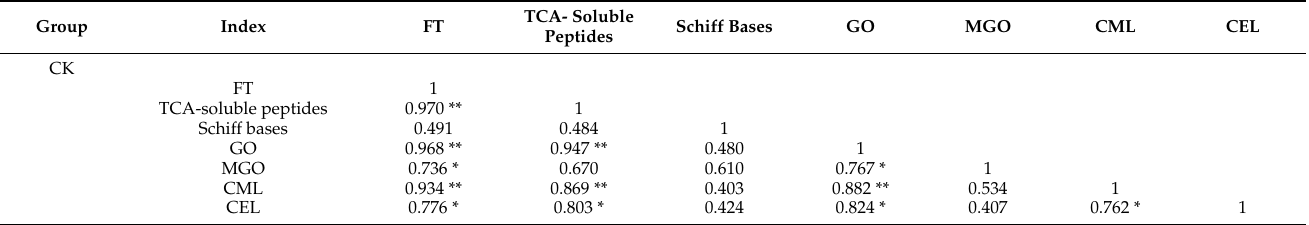
Table 3. Correlation analysis between freeze–thaws (FT), TCA-soluble peptides, Schiff bases, GO, MGO, CML and CEL indicators in raw